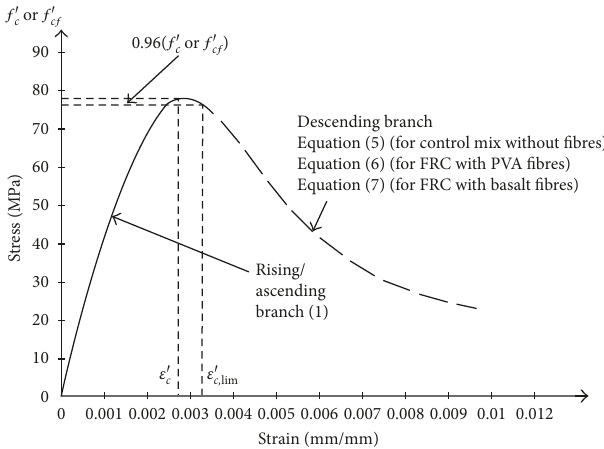
Figure 1: Description of the proposed compressive stress-strain